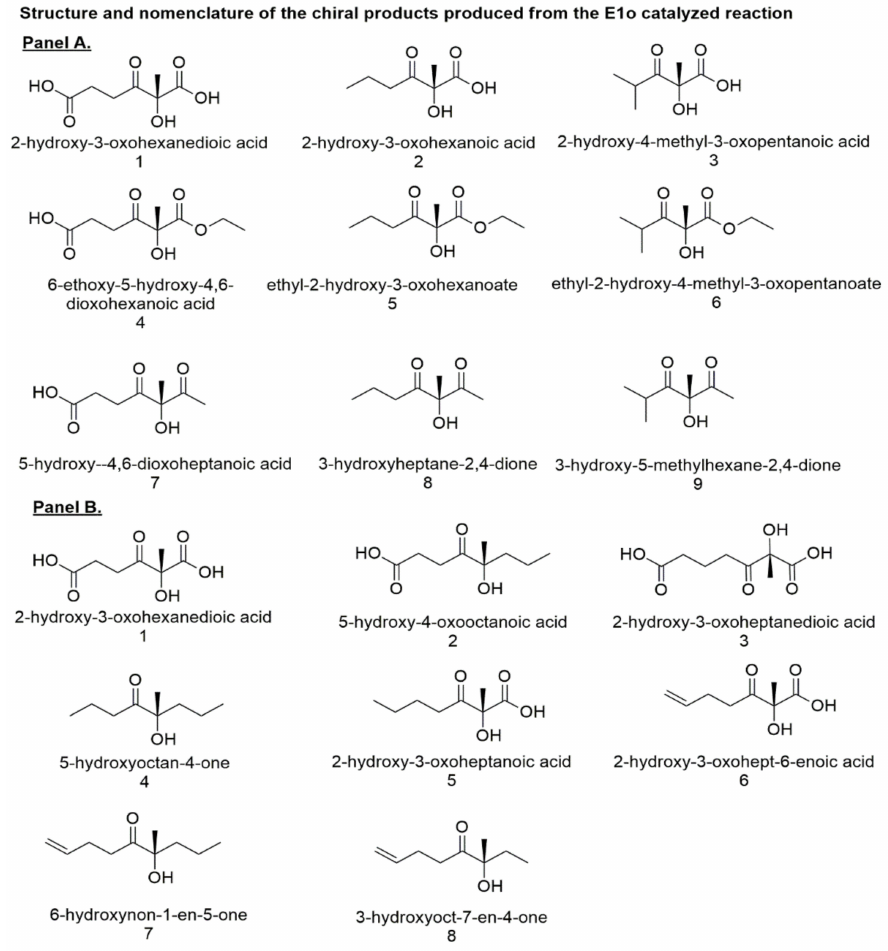
Figure 4. Structure of the chiral products formed by E. coli E1o in carboligation reaction by using different acceptors and substrates in Figure 2 (top and bottom) [69,97]. The formation of products 1 and 3 by using 2-OG and 2-OA as substrates and glyoxylate as an acceptor was also demon- strated for the human E1o [63,64,69]. Panel A represent all chiral products corresponding to Table 2. Panel B represent chiral products using carboxylic acids which are structurally similar to 2-oxo acids (2-oxoadipic acid, 2-ketohexanoic acid and 2-oxo-5-hexenoic acid) and acceptors (glyoxalate, butyraldehyde and